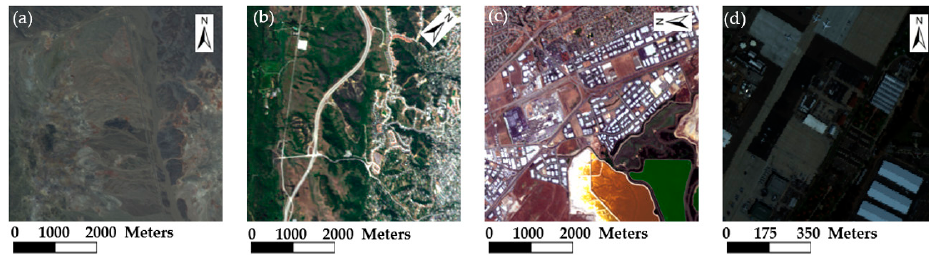
Figure 5. Synthetic RGB images of the test HSIs, taken by AVIRIS with bands 28, 19, and 10 as red, green, and blue, respectively: ( a ) Cuprite; ( b ) Jasper-Ridge; ( c ) Moffett-field; and ( d ) San Diego.